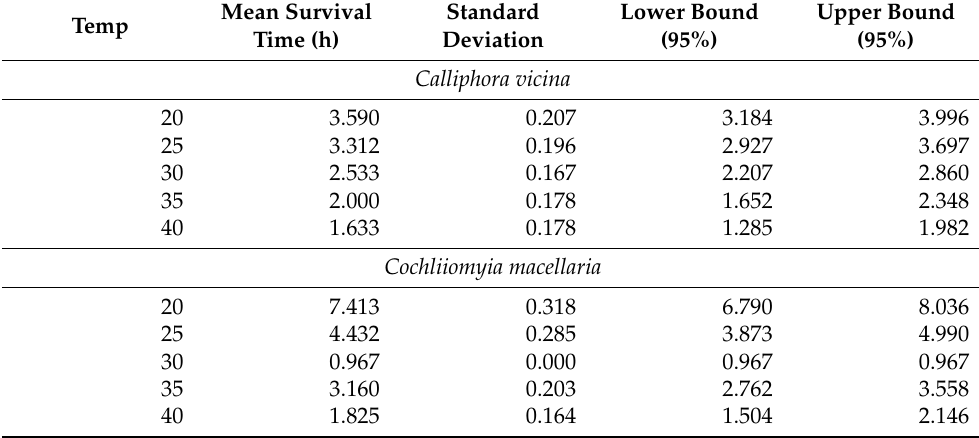
Table 3. Estimates of mean survival times, standard deviation, and 95% confidence limits, at 5 temperatures for 3rd-stage larvae under anoxia for each of 4 species: Calliphora vicina , Cochliomyia macelleria , Lucilia sericata , and Phormia regina . Mean Survival Temp Time